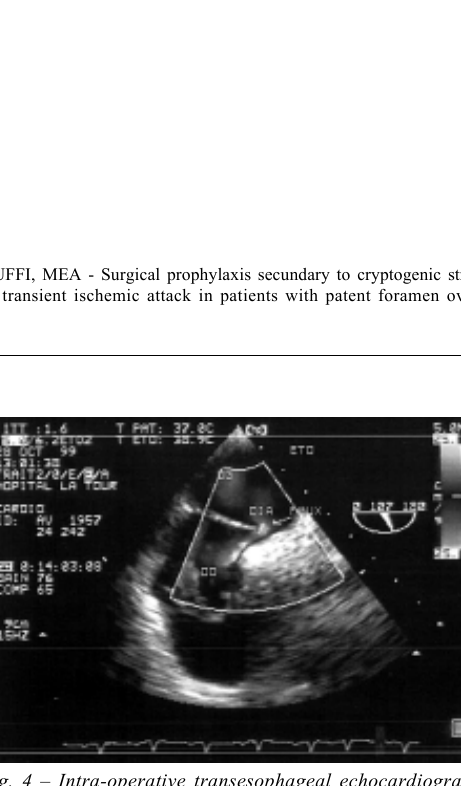
Fig. 5 – Intra-operative transesophageal echocardiography after removing the cardiopulmonary bypass demonstrating the absence of residual shunts in the interatrial septum of patient Nº 22 of this series confirming the success of